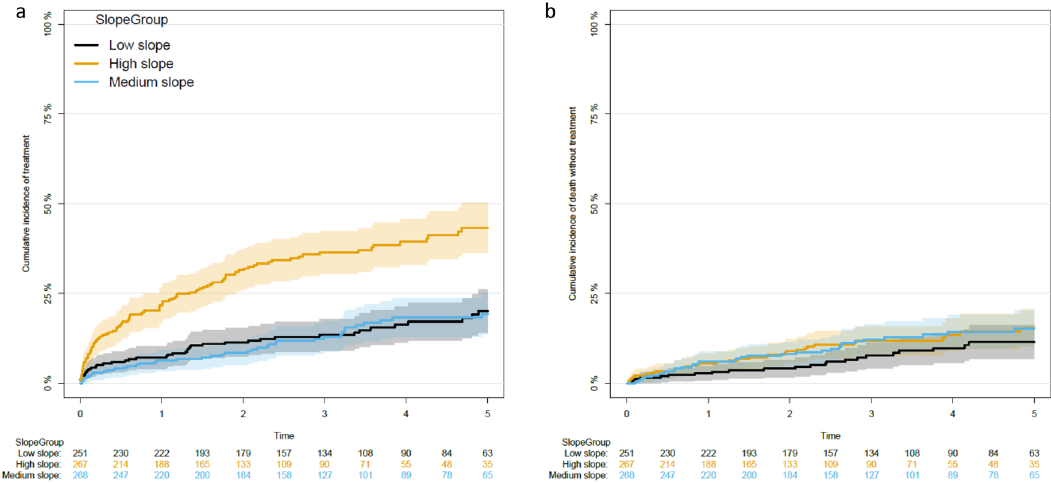
Fig. 3 Cumulative incidence for treatment and death for the three slope groups. Aalen – Johansen cumulative incidence estimates for the three slope groups for treatment ( a ) and death ( b ). Each patient could only have one event, that being whichever came fi rst. Time zero is the time of diagnosis for all patients. The shaded areas for both fi gures are 95% con fi dence